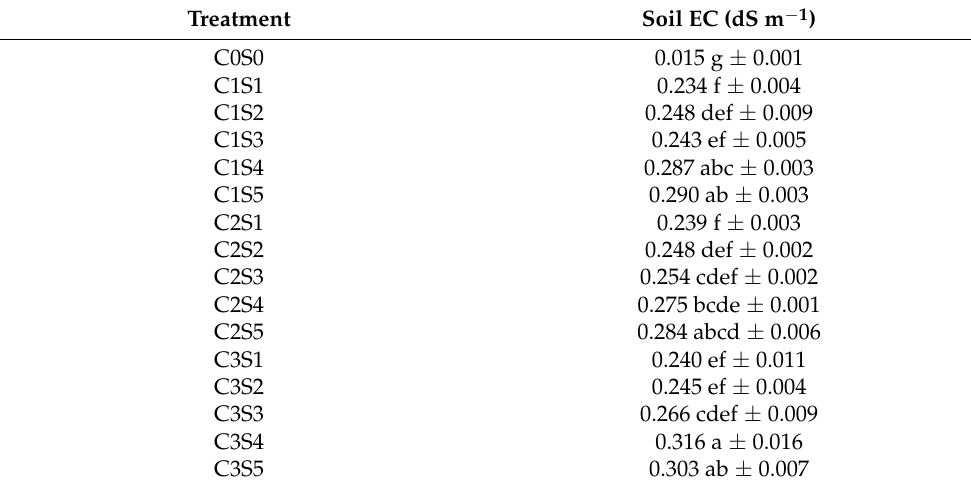
Table 4. Mean soil electrical conductivity for the different treatments after thirty days of leaching.